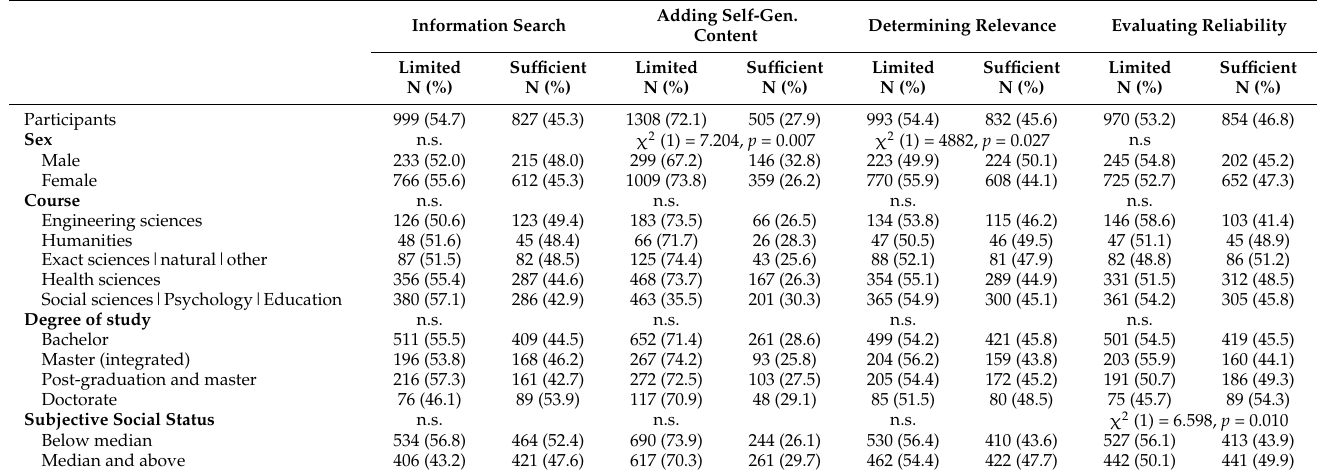
Table 2. Digital health literacy related to COVID-19 and socio-demographics of university